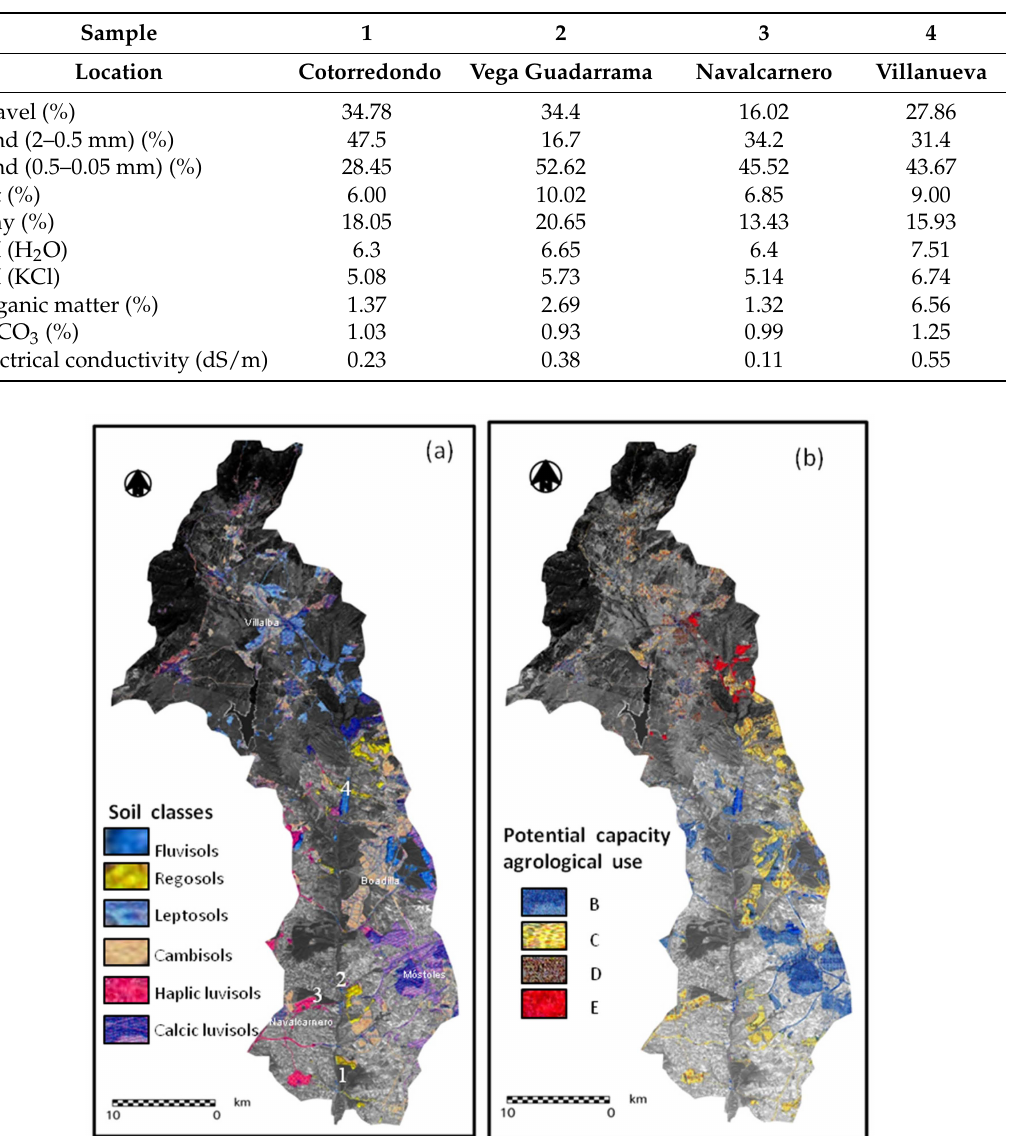
Figure 4. ( a ) Soil associations sealed in 2011 and sample location; ( b ) Sealing in 2011 classified by potential capacity for agricultural